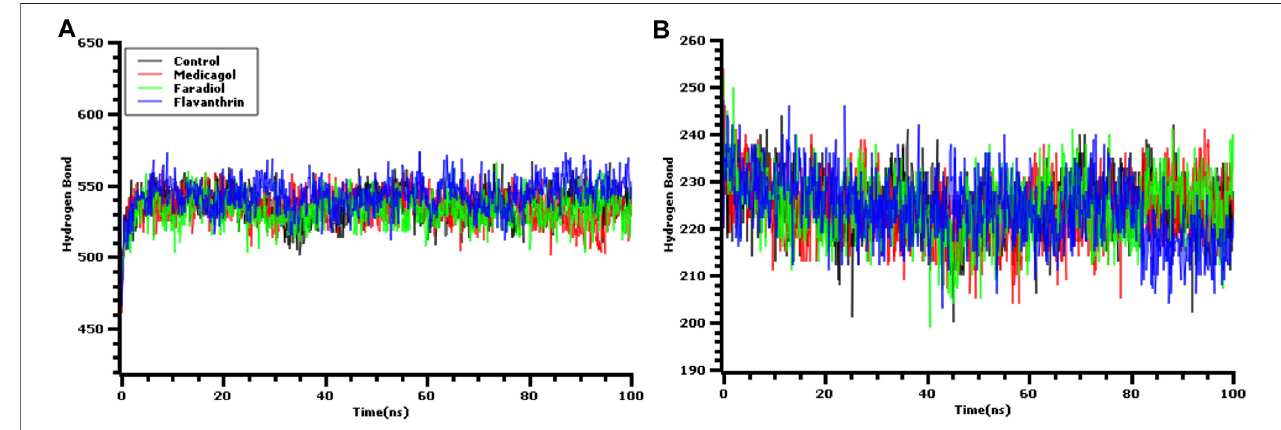
FIGURE 5 | The hydrogen bond analysis from the simulation trajectories where every snapshot were taken into consideration for the graph generations. The (A) hydrogen bond between solute and the solvents, and (B) the hydrogen bond in the solute.